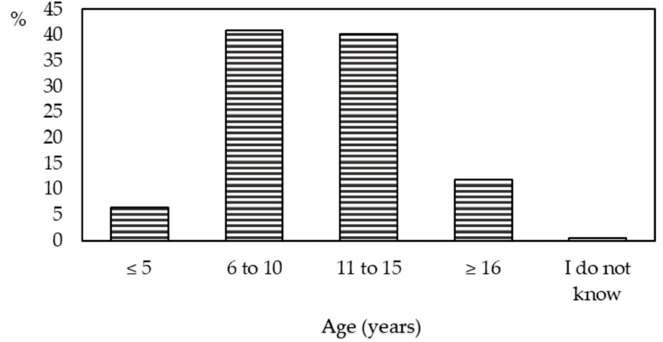
Figure 2. Age at which students (n = 505) believe children should be given a pet to take care